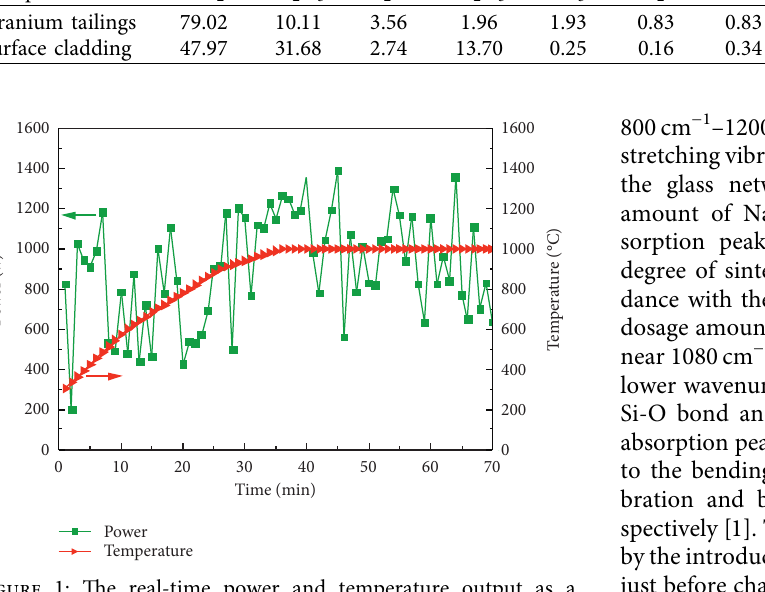
Table 1: Chemical compositions (wt.%) of uranium tailings and surface cladding determined by XRF. Compound